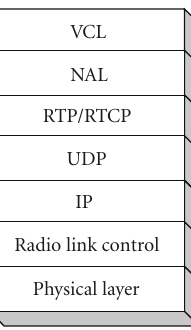
Figure 2: A sample protocol stack for video transmission over